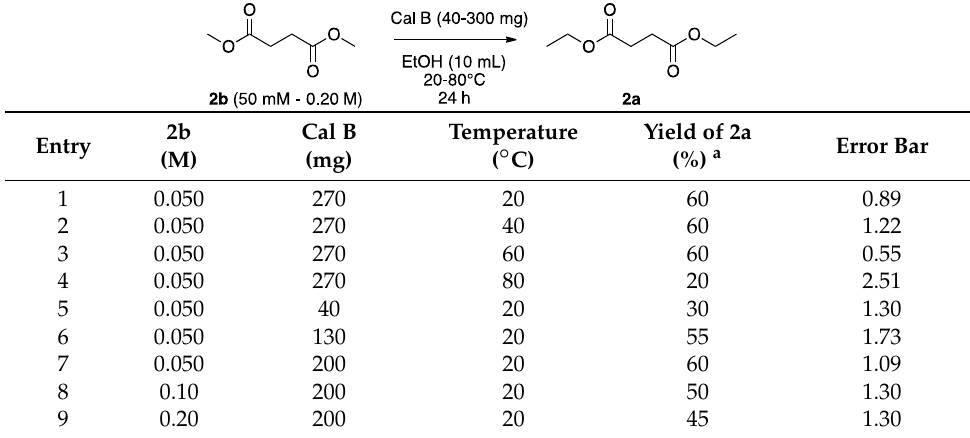
Table 5. Batch chemoenzymatic synthesis of diethyl succinate ( 2a ) by varying the concentration and temperature.